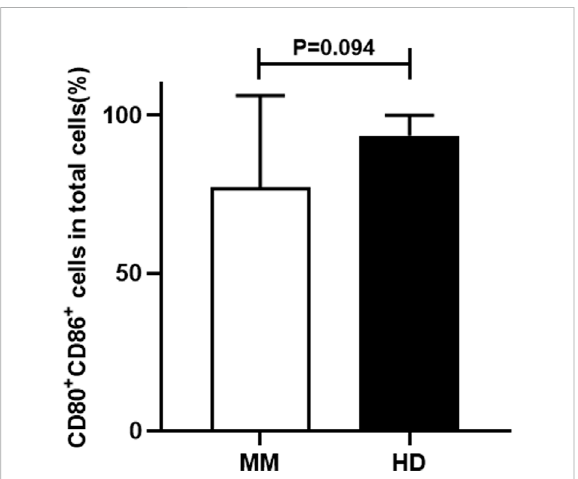
FIGURE 2 The morphology of moDCs. MoDCs are shown by the red arrow (100 μ